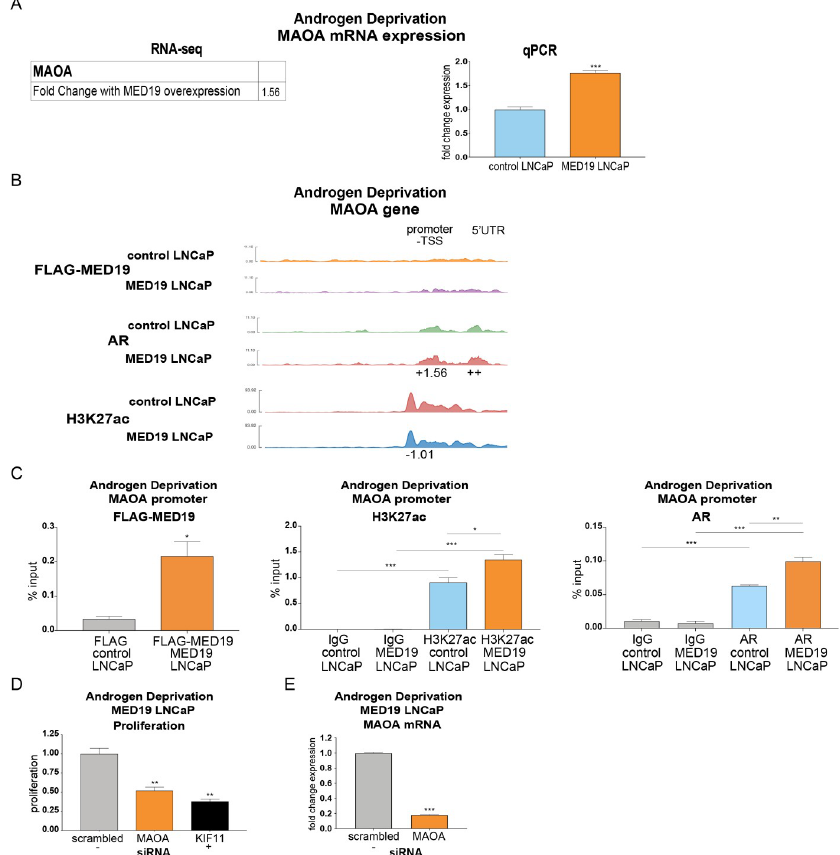
Fig 7. MED19 promotes AR occupancy and H3K27 acetylation at MAOA under androgen deprivation, which controls androgen-independent growth. MED19 LNCaP cells and control LNCaP cells were cultured under androgen deprivation for 3 days and treated with ethanol vehicle (shown) or R1881 (10 nM 16 h for RNA-seq and 100 nM for 4 h for ChIP-seq; shown in S13 Fig). RNA-seq with ribodepletion was performed in biological triplicate. ChIP- seq for FLAG-MED19, AR, and H3K27ac was performed in biological triplicate, with the exception of ChIP-seq for AR in control LNCaP cells + R1881, where one sample was excluded from the analyses because of low signal. A) Fold change mRNA expression from RNA-seq, and qPCR validation of upregulation of MAOA mRNA expression under androgen deprivation (performed in biological triplicate with representative results shown; fold change expression normalized to RPL19 with MAOA mRNA expression in control LNCaP cells set as “1”). B) ChIP-seq tracks (representative results) for FLAG-MED19, AR, and H3K27ac under androgen deprivation shown for promoter region of MAOA. Fold change (up (+) or down (-)) in occupancy scores for MED19 LNCaP cells compared to control LNCaP cells shown for each peak (see S6 Table for all occupancy scores). ++ indicates positive occupancy score in MED19 LNCaP cells and a score of zero in control LNCaP cells;—indicates an occupancy score of zero in MED19 LNCaP cells and a positive score in control LNCaP cells. C) ChIP-qPCR for FLAG-MED19, AR, and H3K27ac at the MAOA promoter overlapping with published ARE. Experiment was performed in duplicate, with representative results shown. D) MAOA was depleted by siRNA and proliferation of MED19 LNCaP cells in androgen-depleted media was evaluated after 7 days, normalized to proliferation with scrambled siRNA treatment (negative control, light grey). KIF11 knockdown is included as a positive control (black). Experiment was performed in biological duplicate, with representative results shown. E) Validation of MAOA knockdown, with MAOA depleted by siRNA and mRNA expression of MAOA in MED19 LNCaP cells cultured in androgen-depleted media measured after 5 days (fold change expression normalized to RPL19, with MAOA mRNA expression with scrambled siRNA treatment set as “1”). � p < 0.05; �� p < 0.01; and ��� p < 0.001. enrichment was reduced under androgen deprivation (S16 Fig). In addition, these motifs were absent at sites of MED19 and AR occupancy in MED19 LNCaP cells where AR was present only in MED19 LNCaP cells. This would be consistent with the ability of ELK1 to act as an AR tethering protein to promote AR recruitment to non-canonical sites.